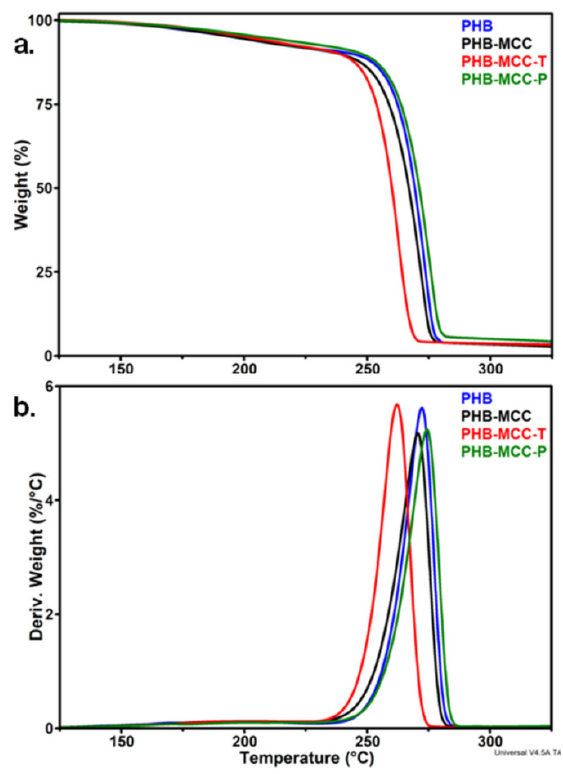
Figure 7. TGA( a ) and DTG ( b ) curves of PHB composites with untreated and treated MCC . Figure 7. TGA ( a ) and DTG ( b ) curves of PHB composites with untreated and treated MCC. Table 3. TGA results for PHB composites with di ff erent treated